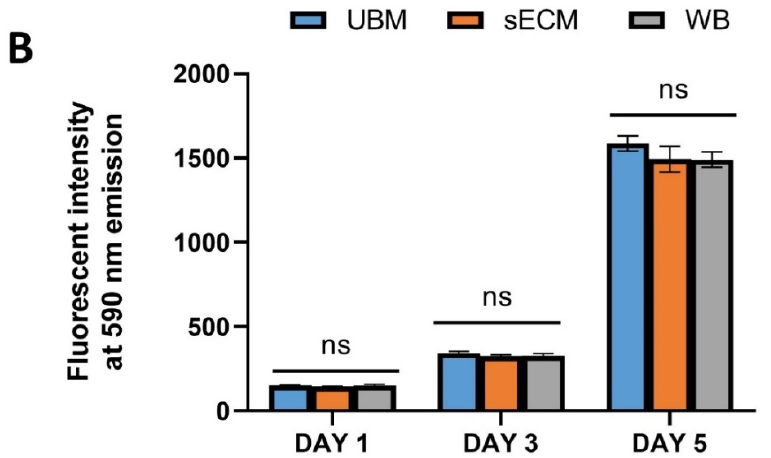
Figure 5. ( A ) Optical images of L929 cells on hydrogel surface after 1, 3 and 5 days. ( B ) L929 cell viability on hydrogel surface evaluated by Alamar blue assay.